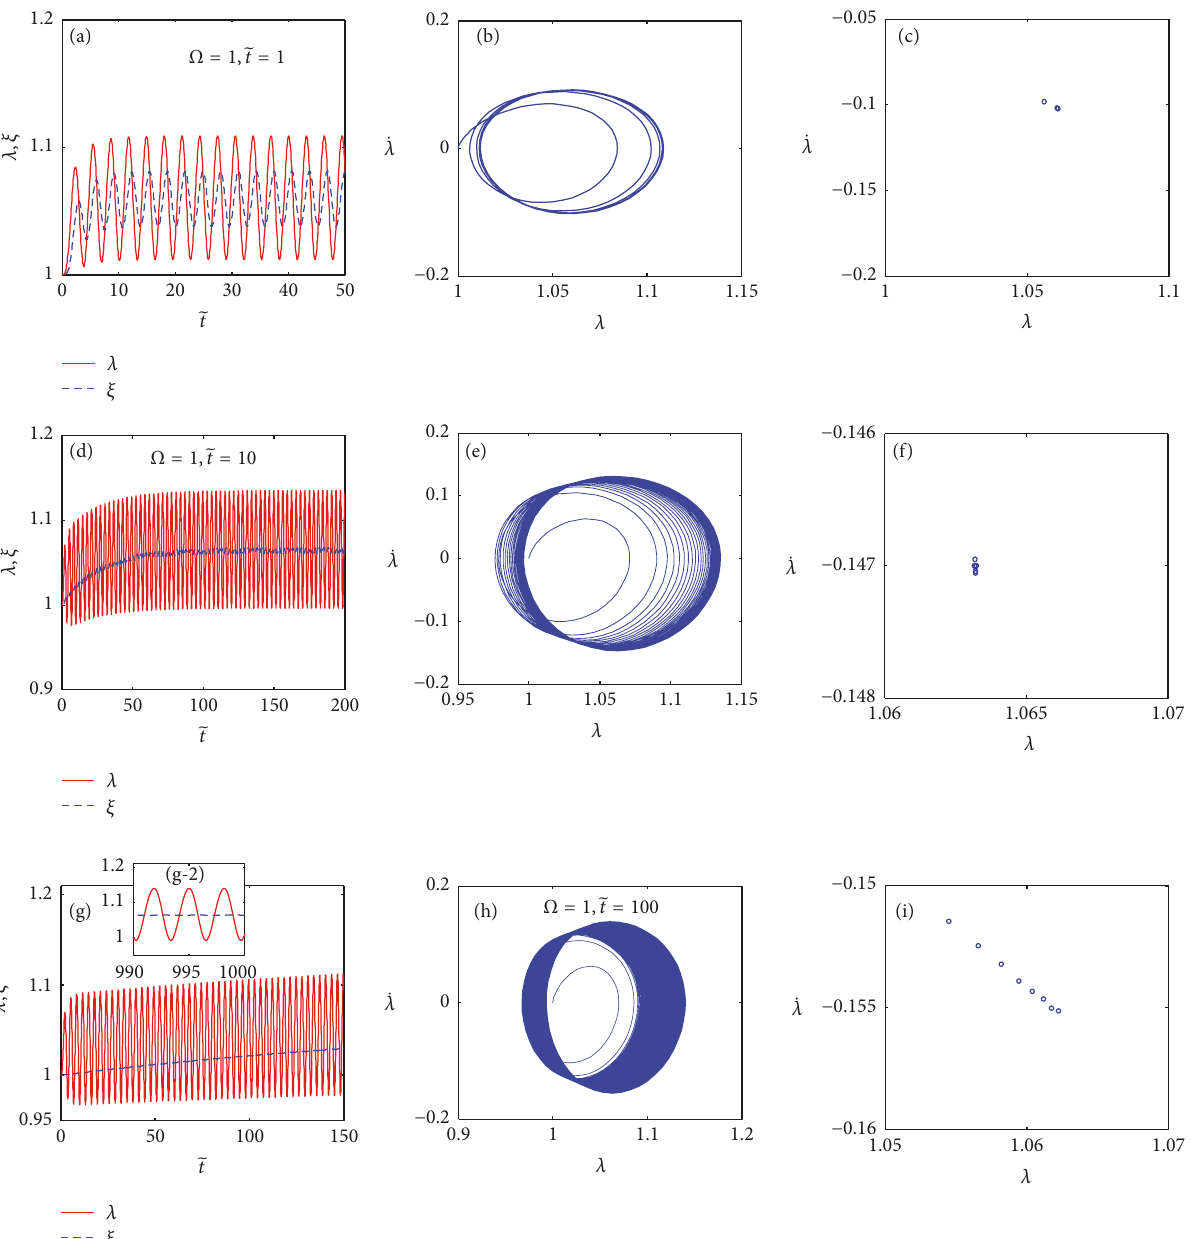
Figure 9: The total stretches 𝜆 , the viscous stretches 𝜉 ((a), (d), and (g)), the phase diagrams ((c), (e), and (h)), and the Poincar´e maps ((c), (f), and (i)) at dimensionless frequency of Ω = 1 for different dimensionless relaxation times ̃𝜏 = 1 , 10, and 100.